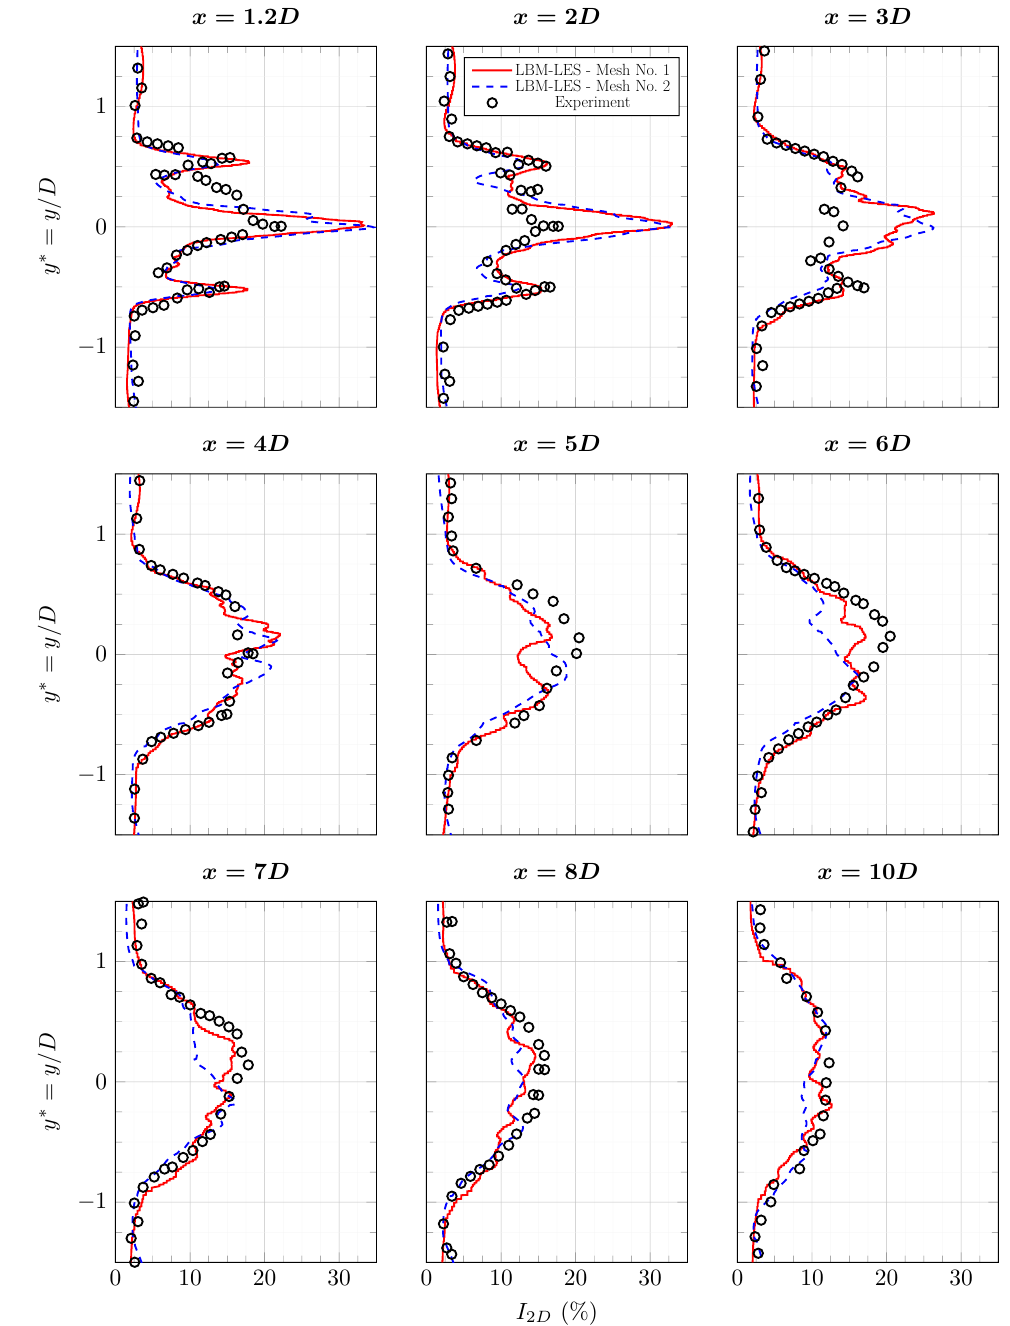
Figure A2. Average turbulence intensity profiles I 2 D in the wake of the tidal turbine at TSR = 3.67 and I = 3%. Results are from experiment [6] and from LBM-LES simulations with mesh Nos. 1 and 2. Complete profile